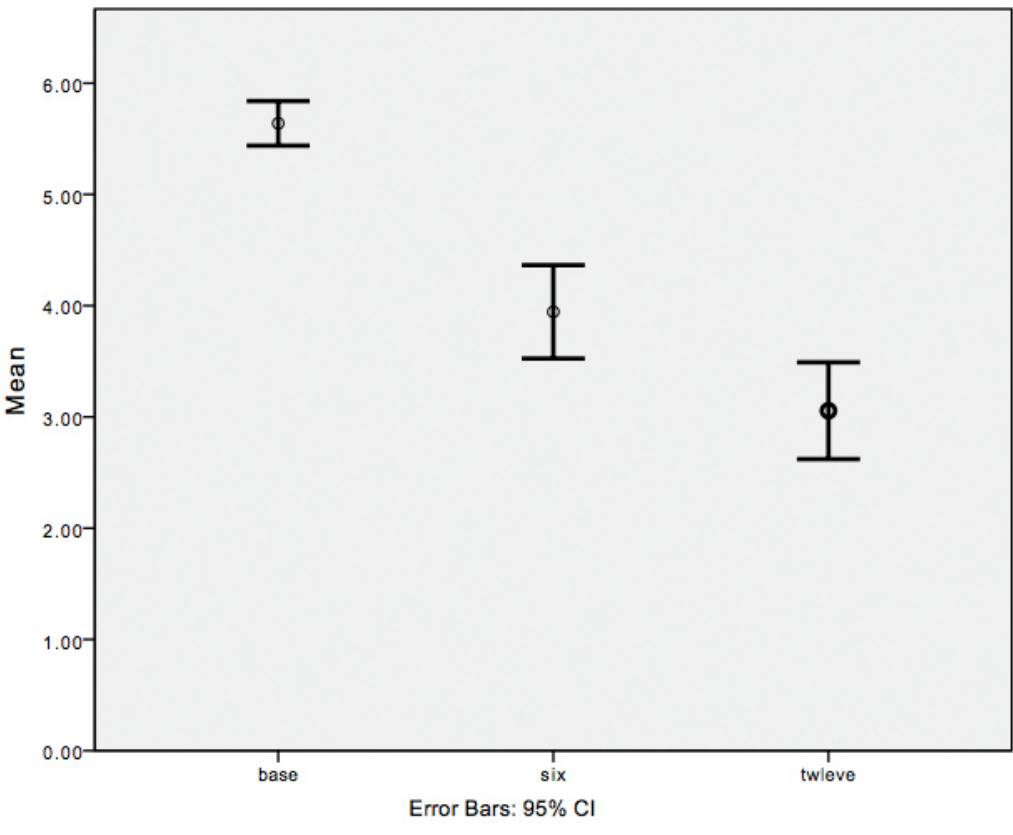
Figure 3. Mean hair shedding scale scores at baseline, six and twelve